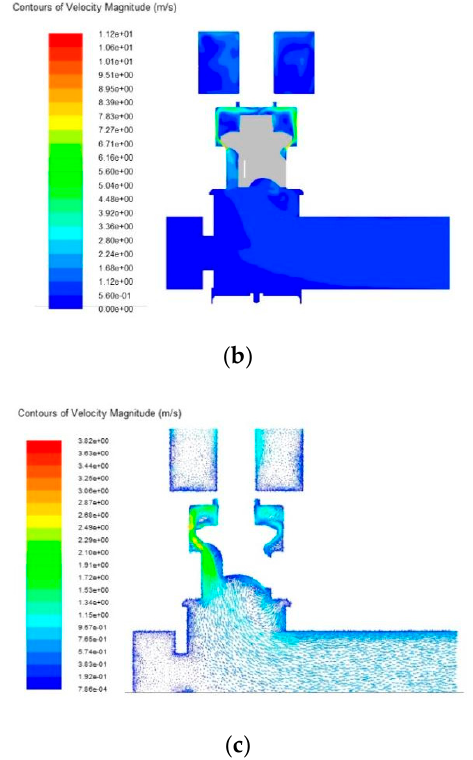
Figure 12. Velocity distribution of the newly developed reciprocating pump for different discharge valve opening lifts: ( a ) 1 mm; ( b ) 2 mm; and ( c ) 12.5 mm.